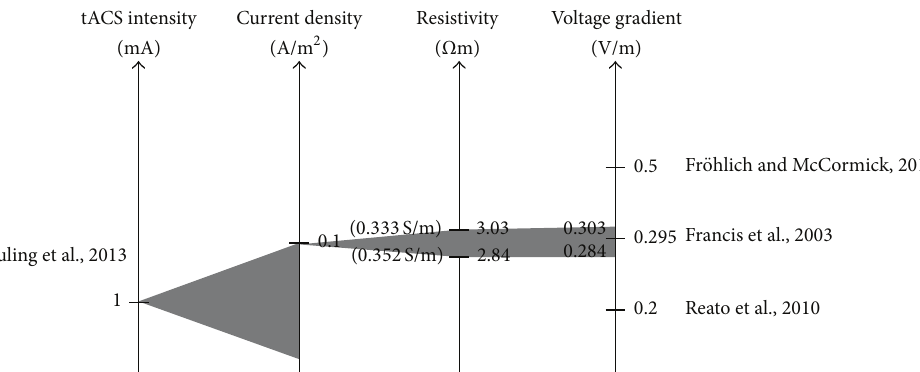
Figure 4: Translation of tACS intensity to intracranial voltage gradients allows a comparison to thresholds for eliciting spikes in animal research. The left axis represents tACS intensity. Neuling et al. [35] applied 1mA intensity (peak-to-peak value: translates to a sine wave of 0.5 mA amplitude). In their FEM, they could show that this intensity results in a number of current densities in different parts of the brain with a maximum of 0.1 A/m 2 (axis: current density). The third axis represents the tissue resistivity of gray matter (tissue conductivity given on the left of the axis in brackets). Values in the range from 2.84 to 3.03 Ω m result in voltage gradients from 0.284 to 0.303 V/m being in the range of thresholds for neural firing or phase-locking (axis: voltage gradient). Note that for voltage gradients 1mV/mm is equal to